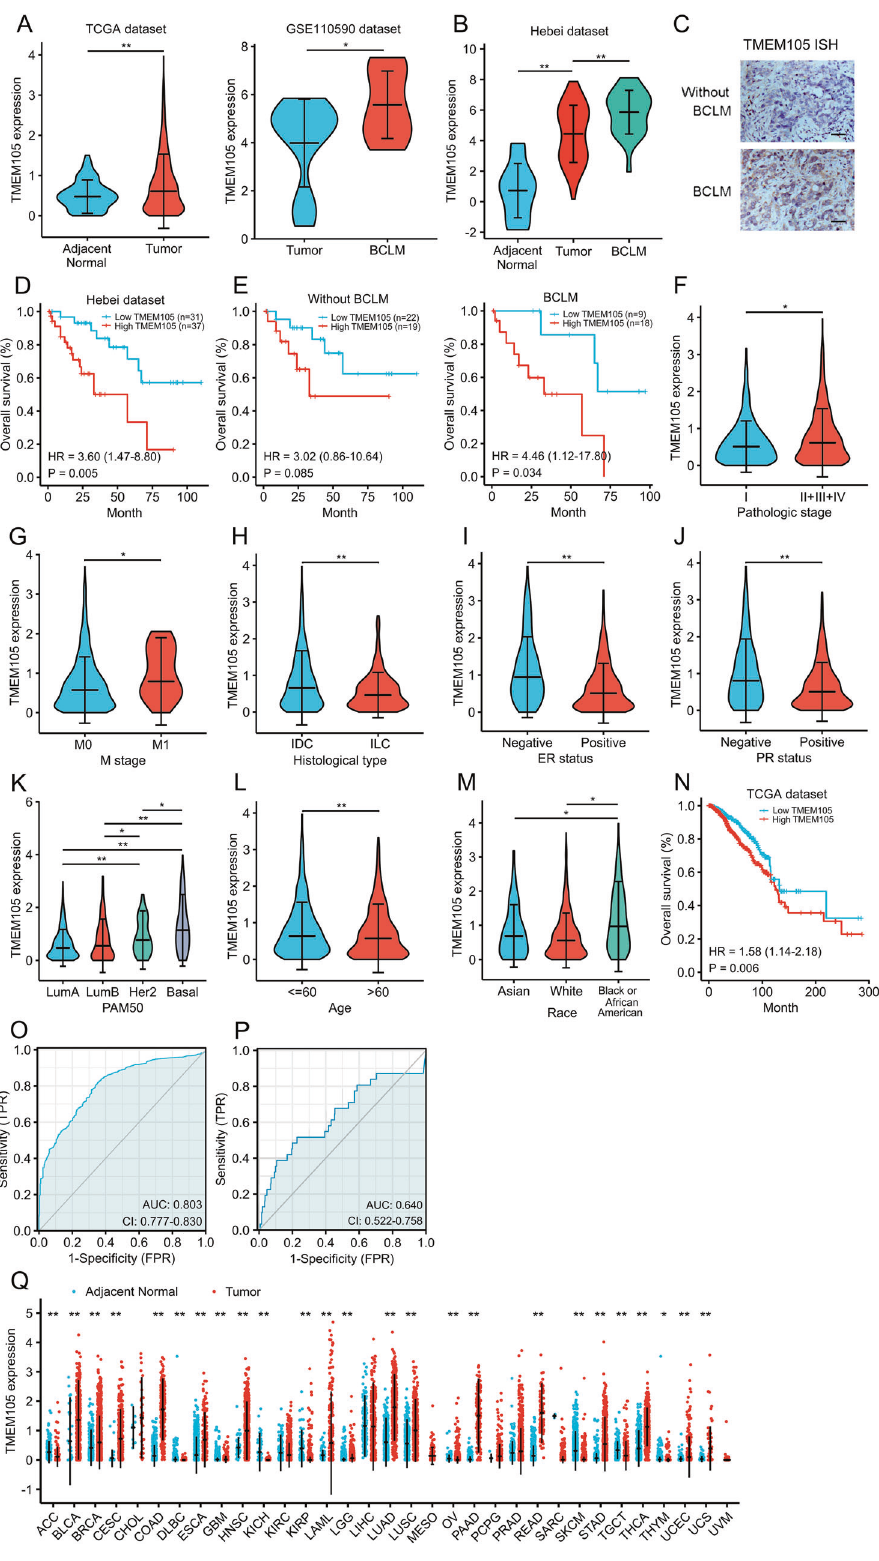
further validate the fi ndings from the analysis of the public datasets, we detected the expression of TMEM105 by qRT-PCR in the specimens from breast cancer patients collected in our institution. Our results revealed that TMEM105 expression was